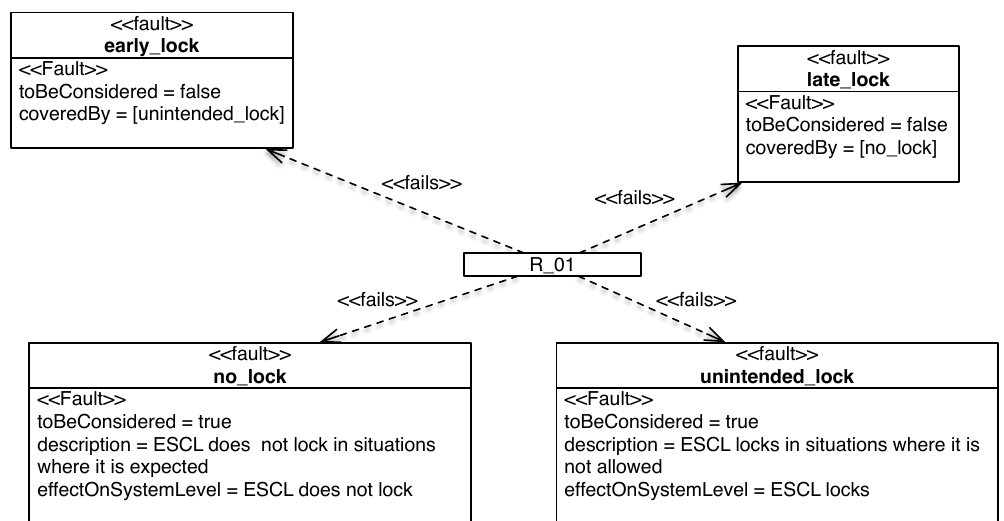
Figure 8. ESCL faults based on [10].